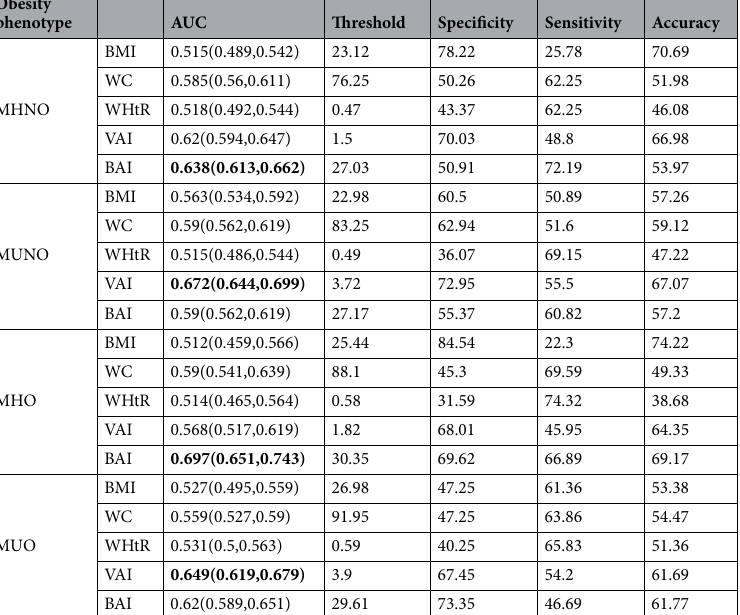
Table 2. Areas under the receiver operating characteristic curve (AUC) for identifying hyperuricemia risk with various adiposity measures within four metabolic health and obesity phenotypes defined by ATP-III criteria. Abbreviations : ATP-III, the Adult Treatment Panel-III; MHNO, metabolically healthy non-obese; MUNO, metabolically unhealthy non-obese; MHO, metabolically healthy obese; and MUO, metabolically unhealthy obese; BMI, body mass index; WC, waist circumference; WHtR, waist-to-height ratio; VAI, visceral adiposity index; BAI, body adiposity